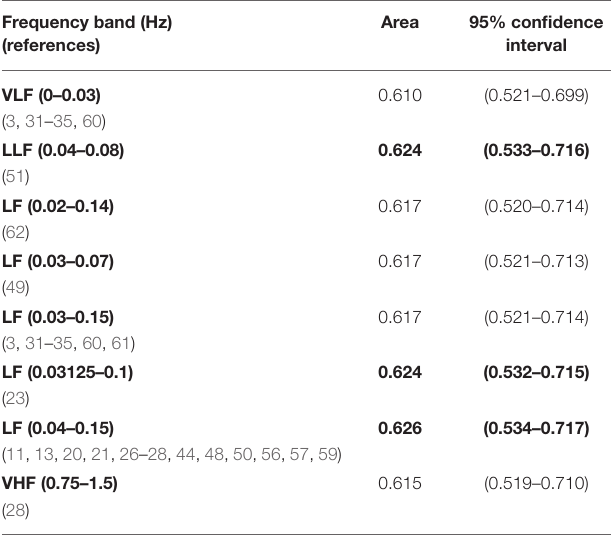
TABLE 3 | Areas under ROC curves and correspondent non-parametric confidence interval, for the band significantly different between groups of